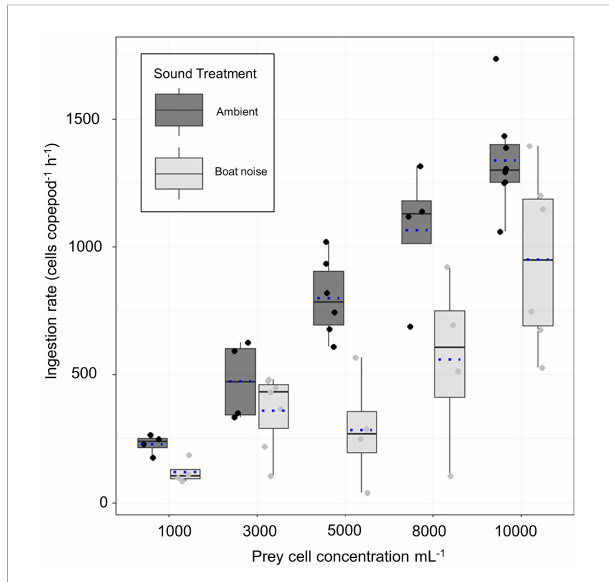
FIGURE 3 Ingestion rates under ambient aquarium sound and harbor noise conditions. The x-axis shows the initial phytoplankton prey cell concentrations from the categories 1000 to 10000 cells ml − 1 . The y-axis presents the ingestion rates that are de fi ned as the number of phytoplankton cells consumed per individual copepod per hour (cells copepod − 1 h − 1 ) calculated after Frost (1972). The boxplots are drawn from the fi rst to the third quartile with a black horizontal line denoting the median and a blue dashed line denoting the respective mean. The whiskers of the plots reaching to the lowest and highest values that is within 1.5 interquartile range. The jittered dots are presenting all values in the data set. Box plots shaded in grey and corresponding dots represent ingestion rates obtained under ambient sound conditions, while light grey colored boxes show ingestion rates when exposed to underwater harbor